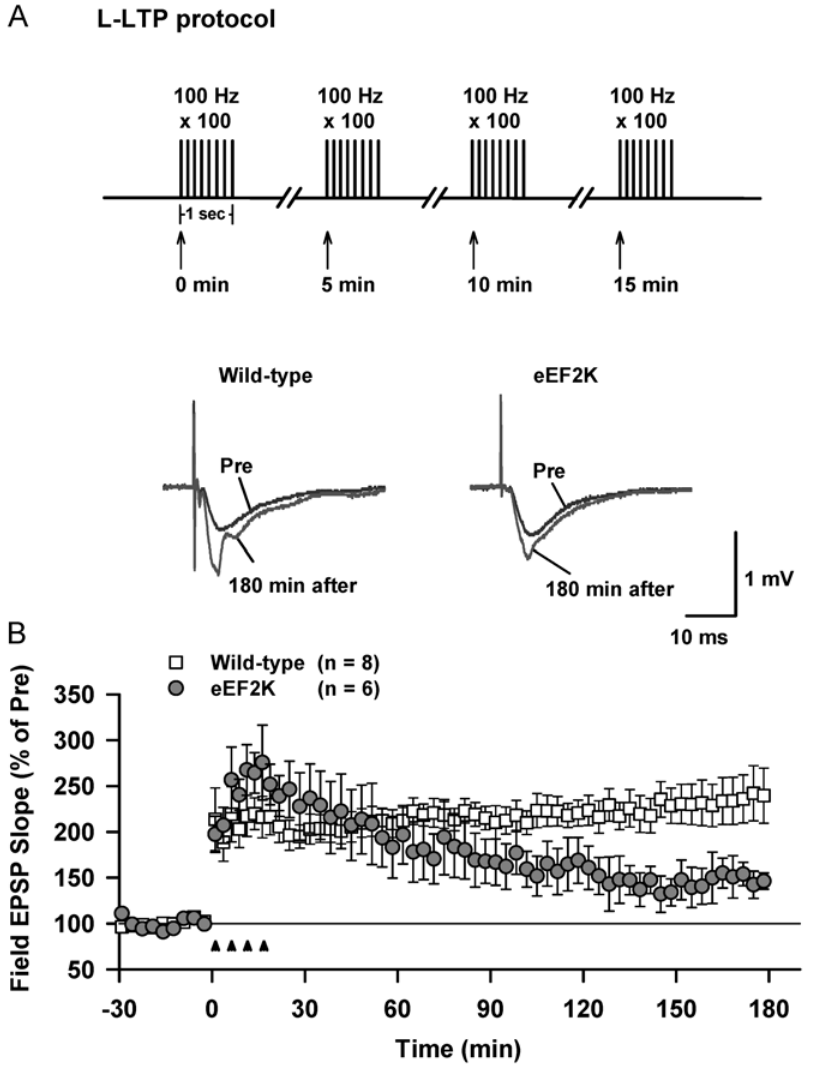
Figure 8. L-LTP, but not post-tetanic potentiation, is impaired in the hippocampus of hip-eEF-2K-tg mice. A . Four trains of high- frequency stimulation (100 Hz for 1 second) made the fEPSP still robust measured at 180 min after the stimulation in wild-type (wt) slices but not in transgenic (tg) slices. B . Quantitative analysis of the potentiation during this 180 min period indicated that there was no significant difference in LTP production (peak) and LTP maintenance before 90 min, whereas there was a highly significant difference exhibited from 90 min up to the whole observation period.